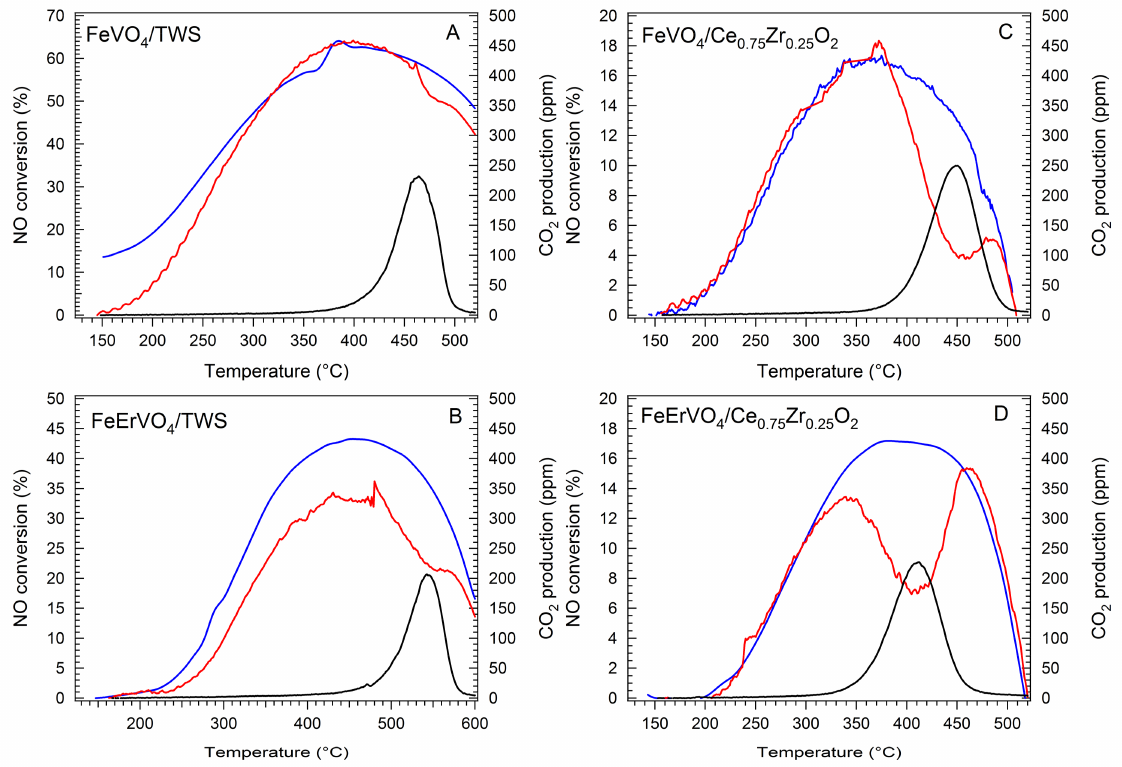
Figure 6. Comparison of 8.4 wt % loaded catalysts under the following conditions: catalyst 20 mg, NO 500 ppm, NH 3 500 ppm, O 2 10%, H 2 O 5%, N 2 balance, and GHSV 900,000 h − 1 . NO conversion in SCR (blue line), NO conversion in SCR combined with soot oxidation (red line) CO 2 evolution (black lines) ( A ) FeVO 4 /TWS, ( B ) FeErVO 4 /TWS, ( C ) FeVO 4 /Ce 0.75 Zr 0.25 O 2 , ( D ) FeErVO 4 /Ce 0.75 Zr 0.25 O 2 . On pure FeVO 4 and Ce 0.75 Zr 0.25 O 2 , negative NO conversion values are obtained (Figure